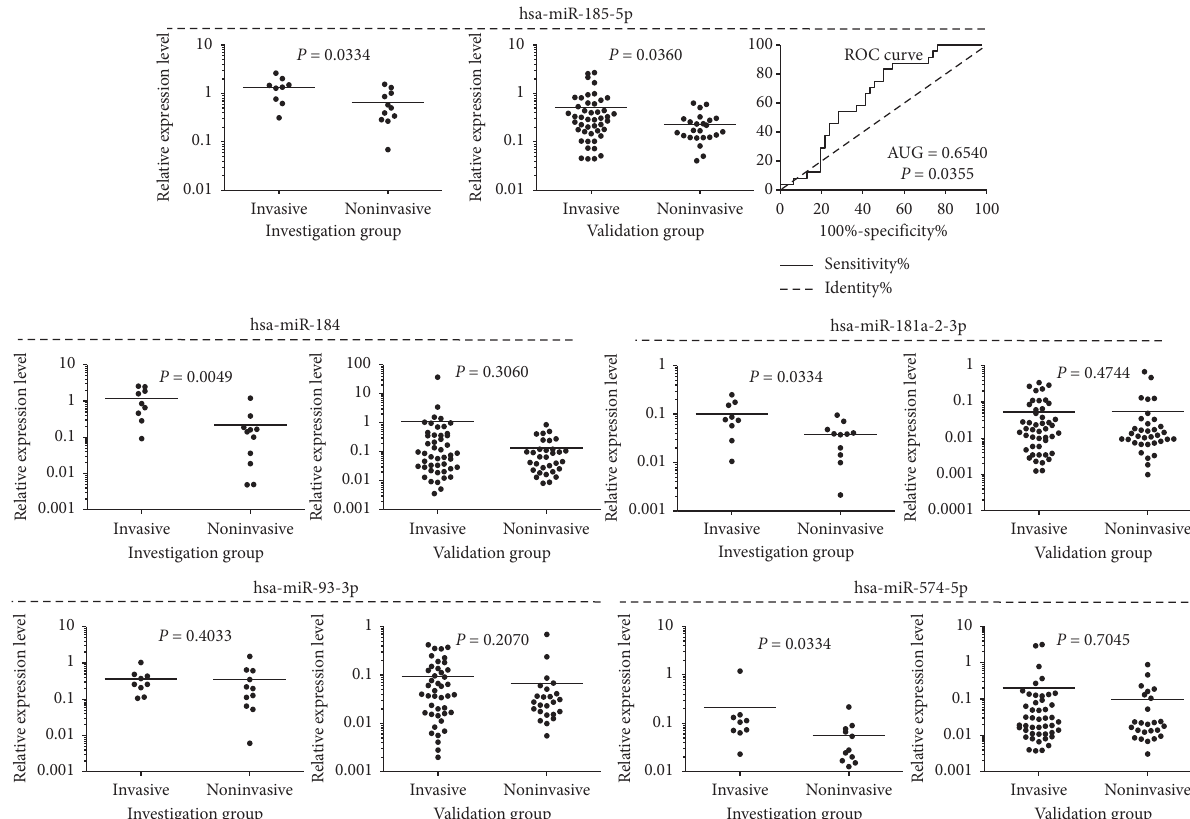
Figure 2: Comparison of invasive and noninvasive gonadotropic PitNETs in terms of expression level of selected miRNAs measured with qRT-PCR assay. Analyses of discovery and validation groups are presented in separate graphs. Mean values are horizontal